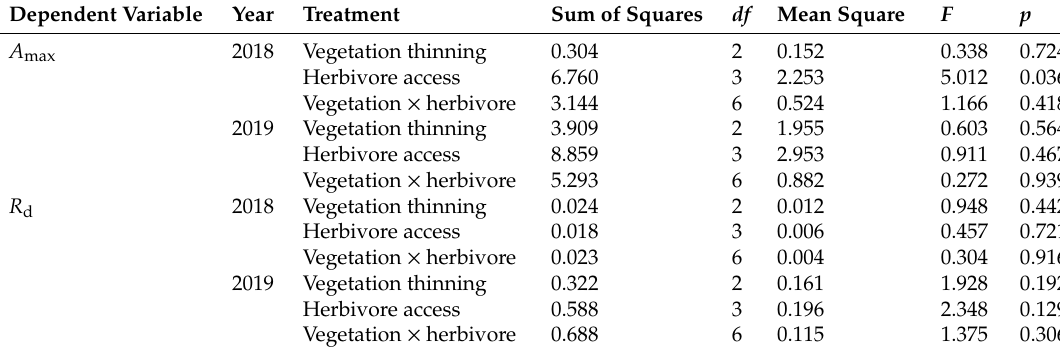
Table 2. Results of two-way analysis of variance (ANOVA) to test for the main effects and interactions of vegetation thinning and vertebrate herbivore access on the leaf-level physiology of Platanthera integrilabia individuals that emerged from tubers planted in early 2018 and 2019 in a forested study site in the Bridgestone–Firestone Centennial Wilderness, TN, USA. All variables were derived from photosynthetic light-response curves; variables include maximum rate of light-saturated photosynthesis ( A max ; μmol CO 2 m −2 s −1 ), rate of dark respiration ( R d ; μmol CO 2 m −2 s −1 ), apparent quantum yield (QY; μmol CO 2 μmol −1 photons), and light compensation point (LCP; μmol photons m −2 s −1 ).